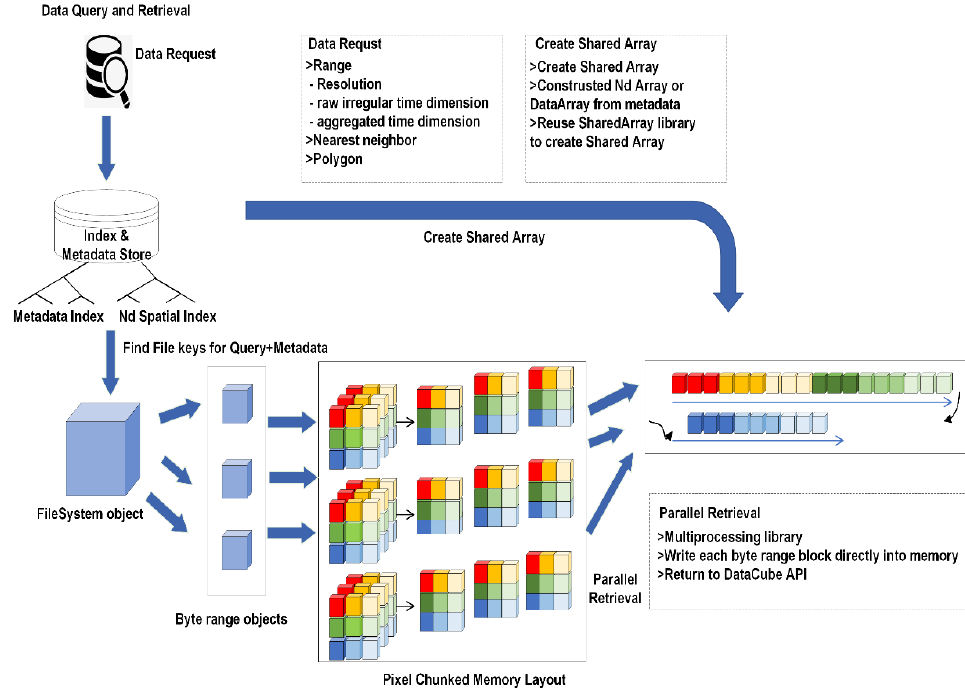
Figure 3. Pixel-based grid data query and retrieval.